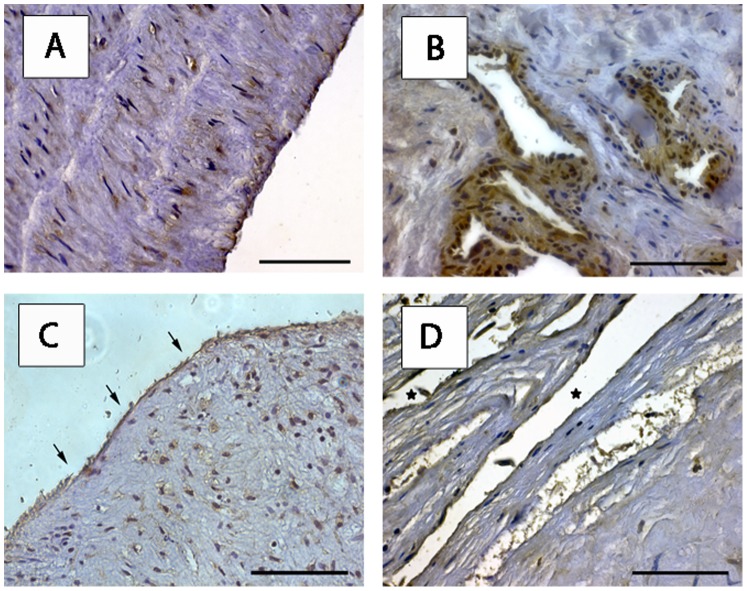
RAGE and HMGB1 expression on endothelial cells of regular PA and endarterectomised tissues.Representative examples of 12 examined patients are shown. Immunohistochemical analysis of regular main pulmonary artery with RAGE expression on endothelium and smooth muscle cells is shown (A). Scale bar: 40 µm. RAGE expressing endothelial cells in vessel-like structures recanalizing the matrix of distal PEA material (B). Endothelial cells expressing RAGE in proximal PEA tissue (arrows point at neointima, C) and HMGB1 (* in recanalizing vessel-like structures, D) in distal PEA specimen are displayed. Scale bar: 20 µm. RAGE receptor for advanced glycation endproducts, HMGB1 high mobility group box 1, PA pulmonary artery, PEA pulmonary endarterectomy.